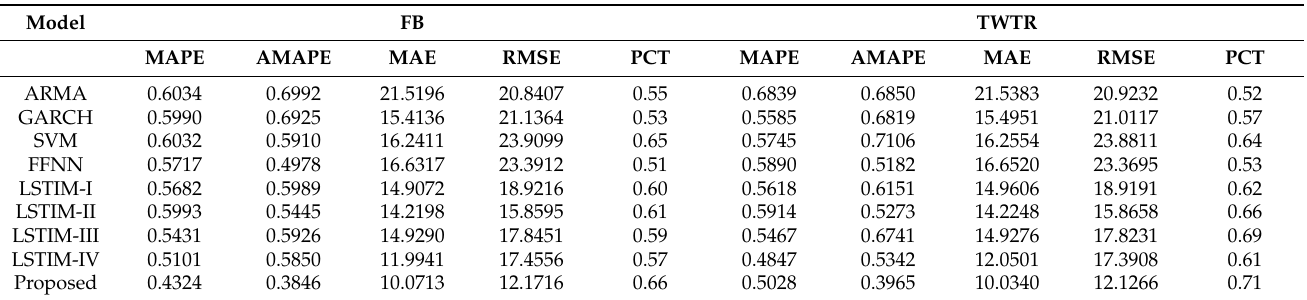
Table 9. Prediction performance for 150 days: FB and